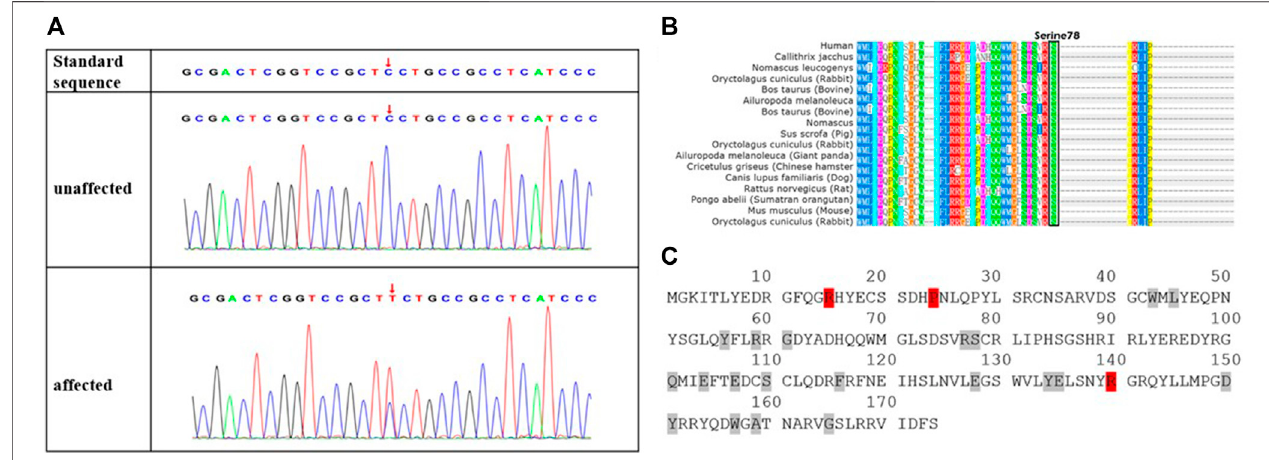
FIGURE 2 | Novel missense mutation (c.233C > T; p.S78F) in CRYGD in a Chinese family with congenital cataract. DNA sequences of CRYGD in affected and unaffected individuals (A) . A heterozygous variant c.233C > T was identi fi ed in exon 2 of CRYGD . The lower chromatogram of the DNA sequence from the affected proband(III:6) showed both Cand Tat theindicatedposition(redarrows in A ).Theupper sequencechromatogramfroman unaffected individual(III: 5)only showed the wild-type CRYGD allele. The mutation codon in crystallin gamma D protein is highly conserved in many species, black box indicted the different species had the serine at 78 codon (B) , and there are 23 reported mutation residues (with red or gray background) in protein sequence of crystallin gamma D (C) . Three (with red background) of these residues are hot spots for mutations, which eventually lead to congenital cataract, while the gray background residues were less frequently